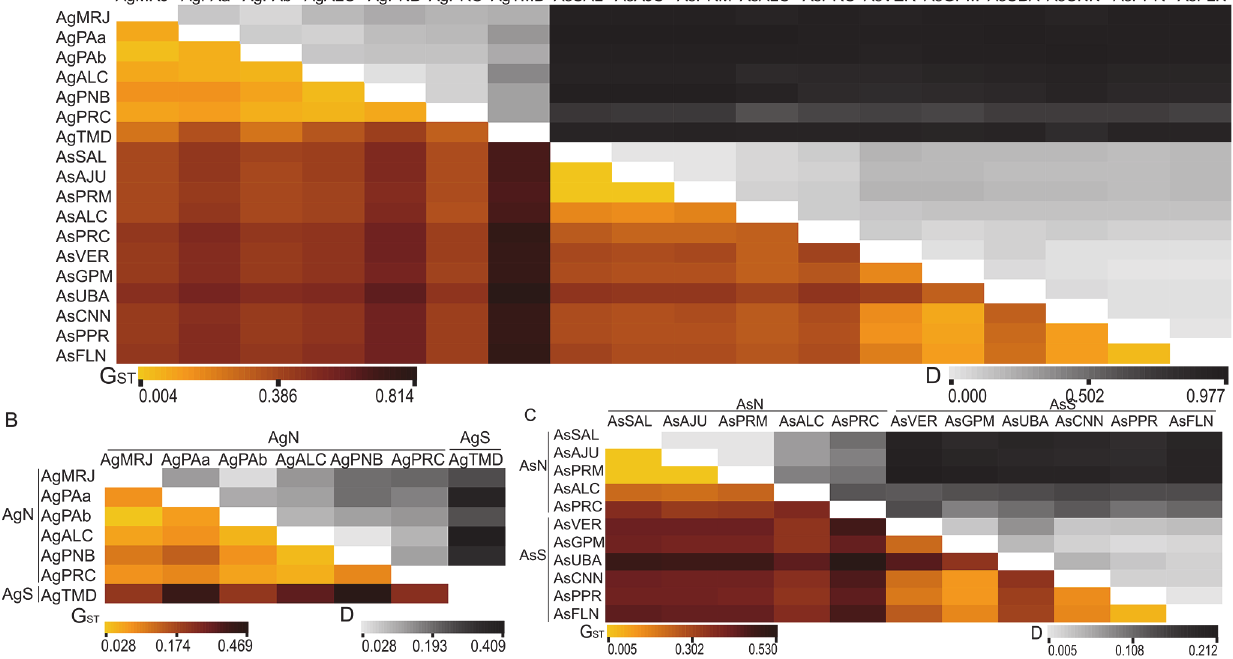
Fig 2. Pairwise comparisons of population genetic differentiation in A . germinans and A . schaueriana . Pairwise measurements of the genetic variation between samples in terms of Nei ’ s G ST (1973 — below diagonal) and D (Jost 2008 — above diagonal) values in A) both A . germinans and A . schaueriana , B) A . germinans , and C) A . schaueriana samples. AgN and AgS and AsN and AsS refer to samples of A . germinans and A . schaueriana taken from locales north and south of the NEESA, respectively. All measures were significant (p <